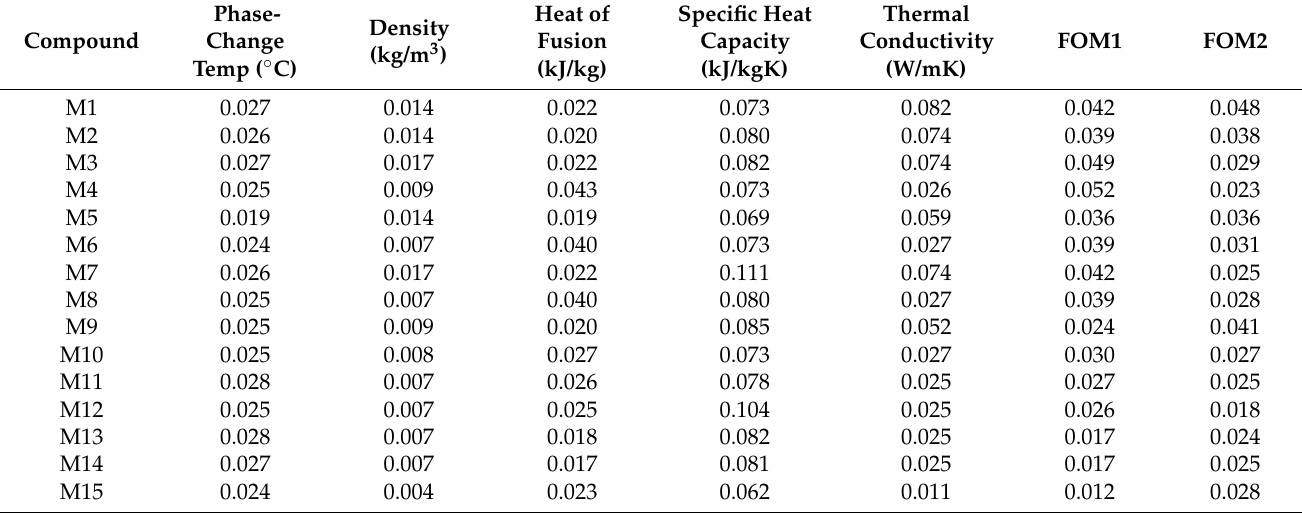
Table 13. TOPSIS weighted